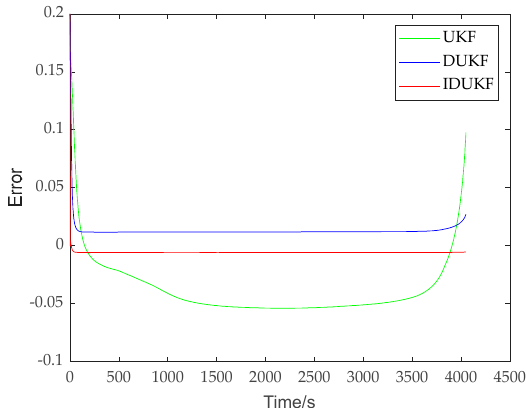
Figure 18. The error curves in the VCCC tests.